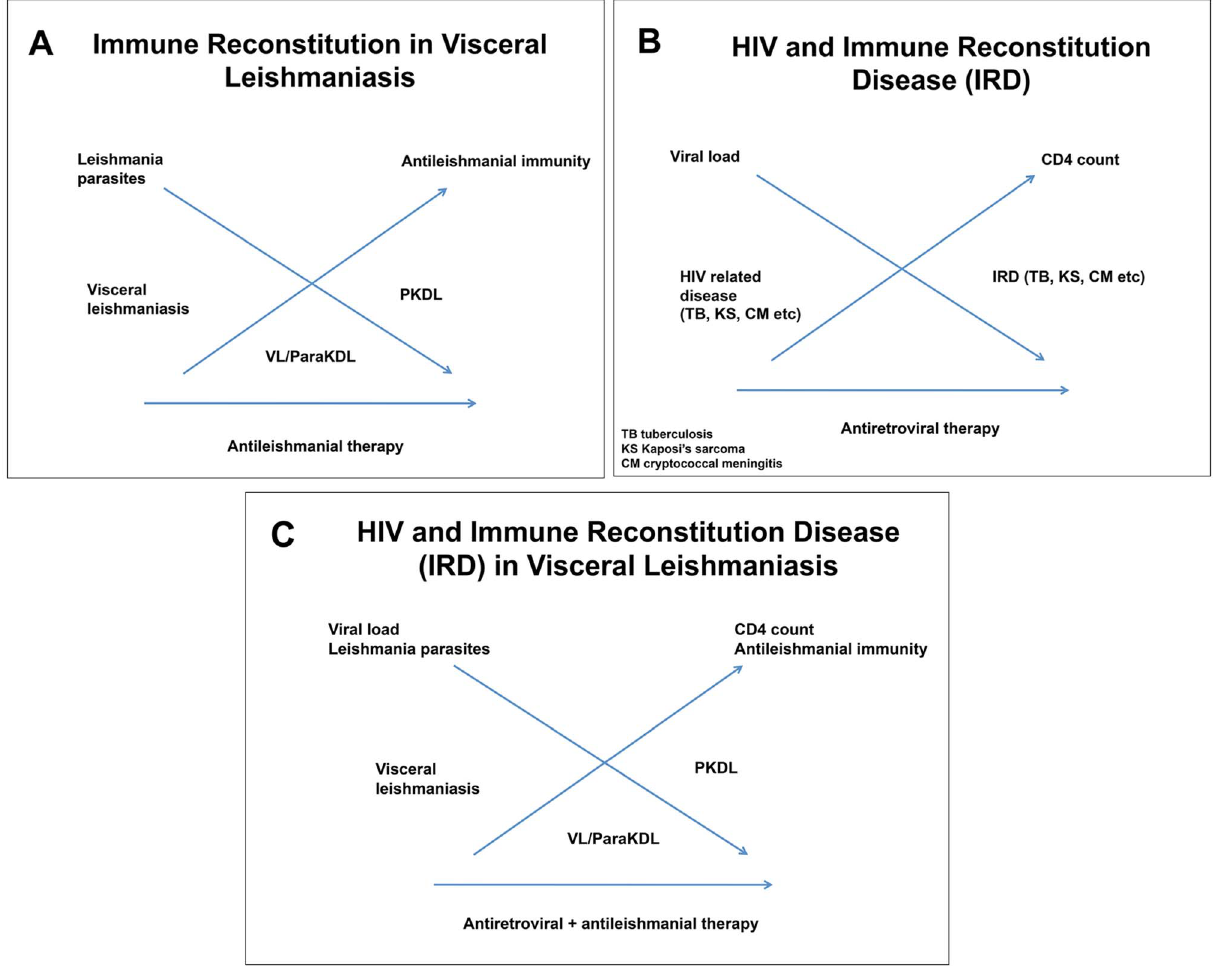
Figure 3. Immune (re-)constitution and post-kala-azar dermal leishmaniasis (PKDL). Panel A : Immune constitution in PKDL in immunocompetent patients. Theoretical relationship between changes in parasite load and immune response as the result of antileishmanial treatment, with associated clinical syndromes (visceral leishmaniasis [VL], PKDL) Panel B : Immune reconstitution in HIV infection. Theoretical relationship between changes in viral load and CD4 count as a result of antiretroviral therapy, with examples of associated immune reconstitution disease (cryptococcal meningitis, Kaposi’s sarcoma, tuberculosis). Panel C : Theoretical overlap in mechanisms of PKDL occurring during VL and HIV co- infection treated with combined antileishmanial and antiretroviral therapy.